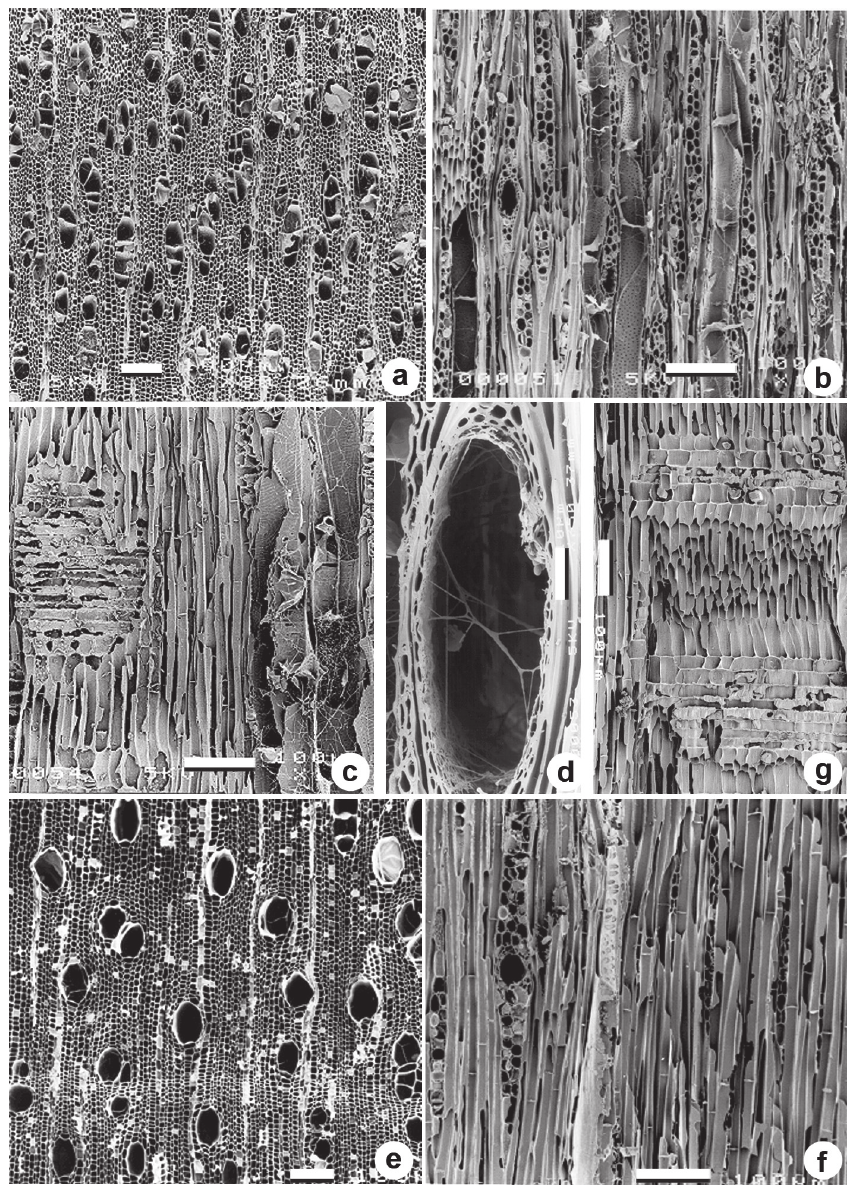
Figure 4. a-d . Schinus terebinthifolius (SPSFw 479). - e-g . Tapirira obtusa (BCTw 3863). Platinum-coated, UM-II. - a,e : Transverse section. - b,f : Tangential section. - c,g : Radial section. - d : Radial canal. - Bars = 100 µm ( a-c , e-g ) and 20 µm ( d